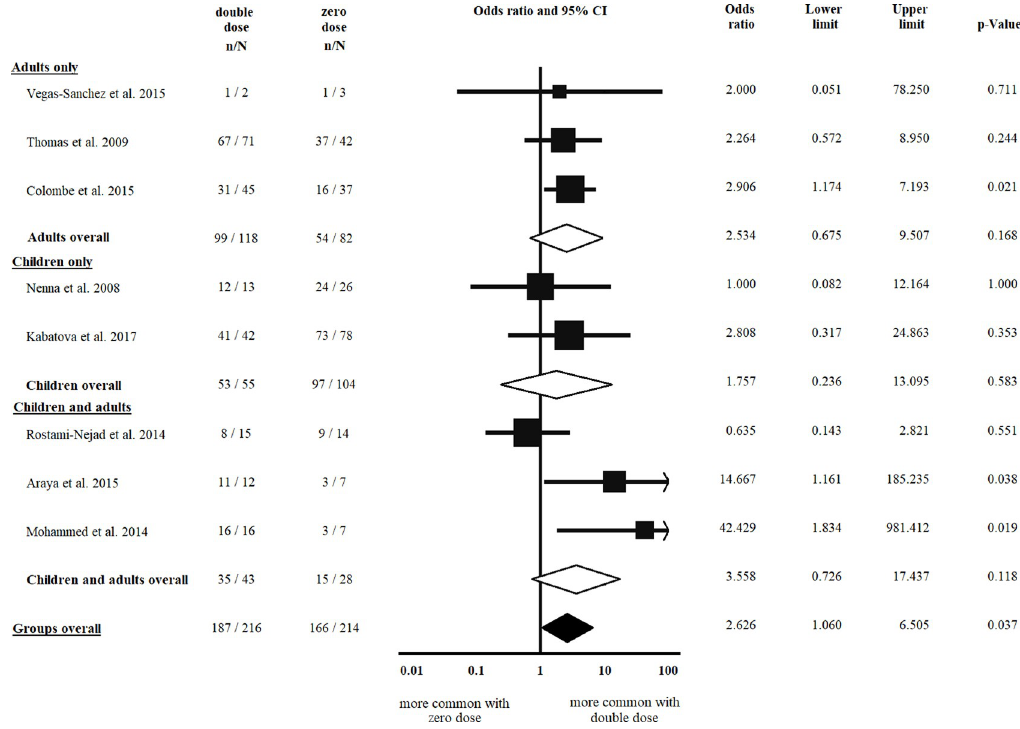
Fig 5. Odds ratios of atrophic histology at diagnosis with double dose vs. zero dose of HLA-DQB1 � 02. Patients with a double dose of the allele were more likely to have villous atrophy at diagnosis than those with a single dose of the allele. Heterogeneity of the groups overall: I 2 = 21.3%, p = 0.260; heterogeneity of the subgroup of adults: I 2 = 0.0%, p = 0.945; heterogeneity of the subgroup of children: I 2 = 0.0%, p = 0.542. CI: confidence interval.